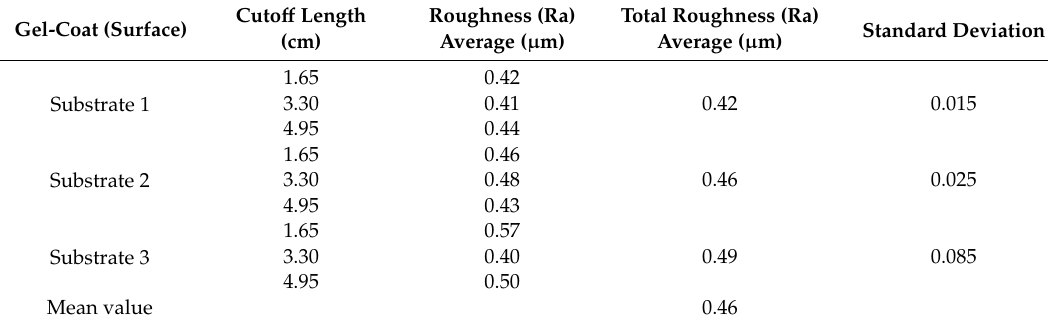
Table 2. Results of the roughness test of our